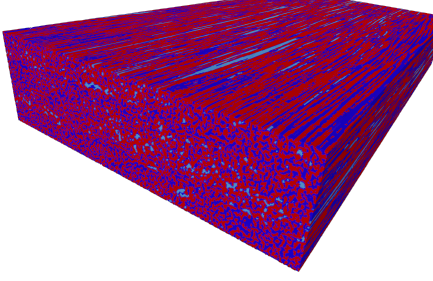
Figure 10. The real tomography-scanned 3D part: red is used for the fibers, the dark blue is the matrix, and the light blue is the air